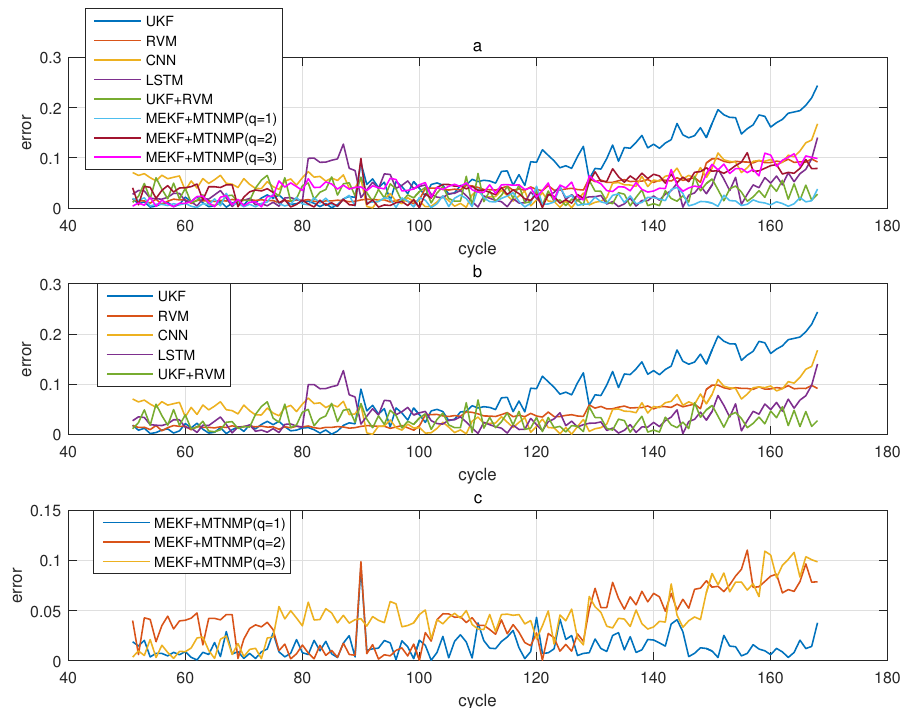
Figure 13. The simulation error diagram of B0007 predicted from the 50th time. ( a ) is the experimental error of all methods, ( b ) is the error of other methods used for comparison in ( a ), and ( c ) is the error of the method proposed in this paper in ( a ).